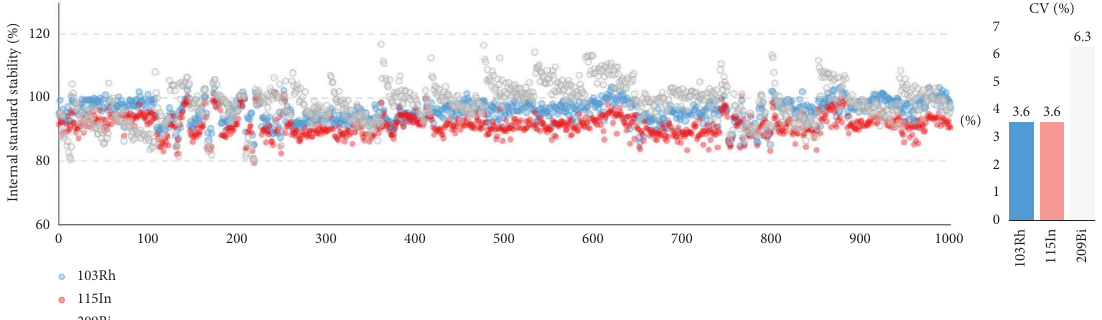
Figure 6: Te scatter plot and coefcient of variation (CV) for the internal standard stability from the ICP-MS hair analysis of a thousand maternal hair samples using O-MicroD